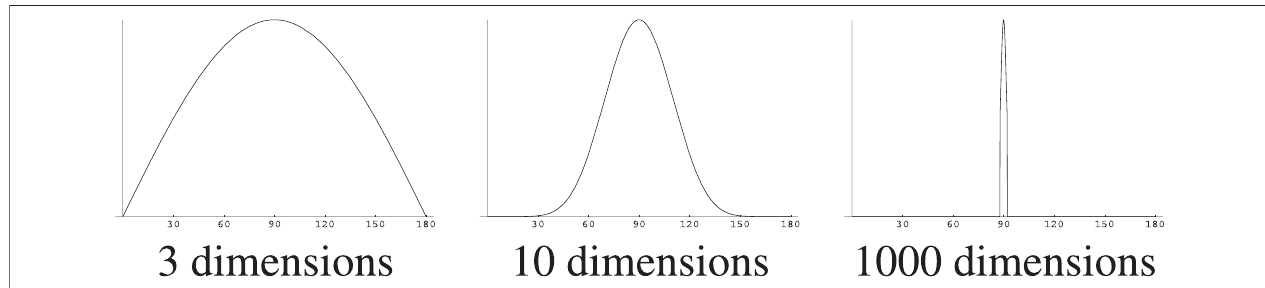
FIGURE 1 | The distribution of angles between two randomly chosen points on spheres of various dimensionalities [Figure by Anders Holst, from Karlgren et al. (2008)].